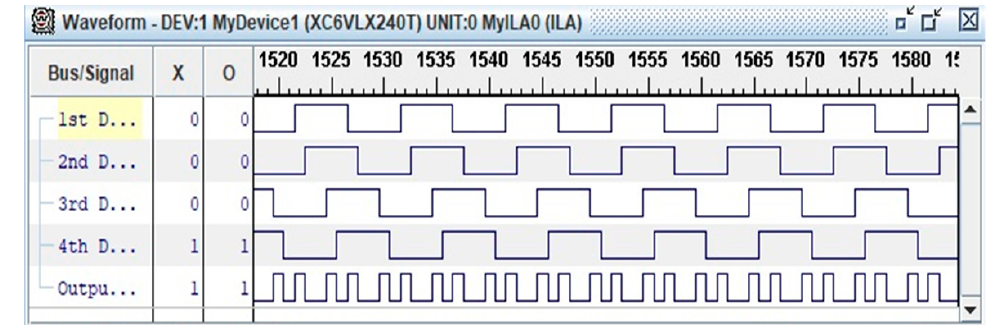
Figure 13. Waveform from ChipScope Pro Analyzer function.